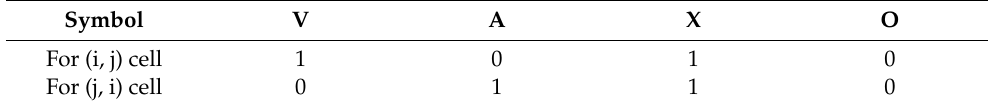
Table 4. Conversion rule of SSIM matrix into initial reachability matrix.